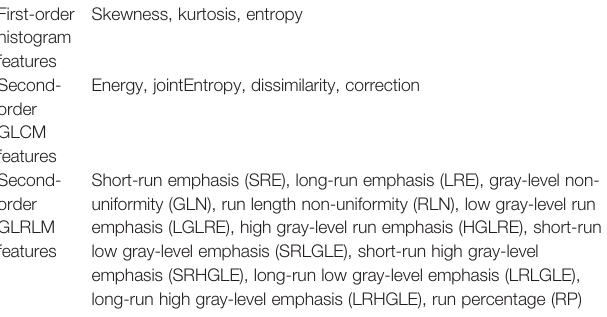
TABLE 1 | First- and second-order radiomics features shared the same de fi nition in the two packages. First-order histogram